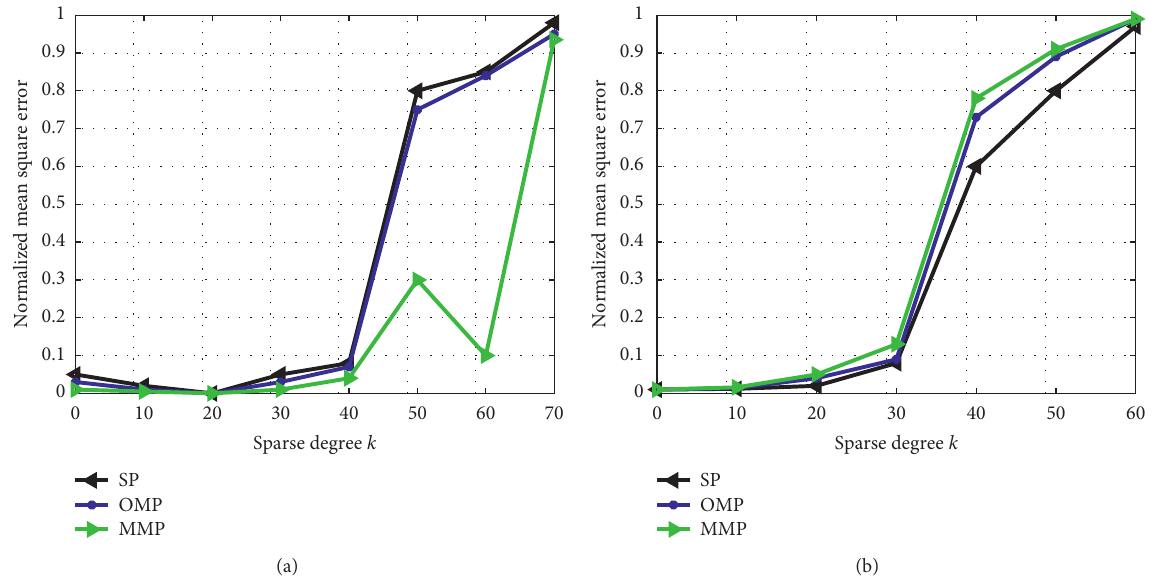
Figure 6: .Variation of reconstruction errors of different greedy reconstruction algorithms with sparsity K. (a) Gaussian signal. (b) 0-1 signal.